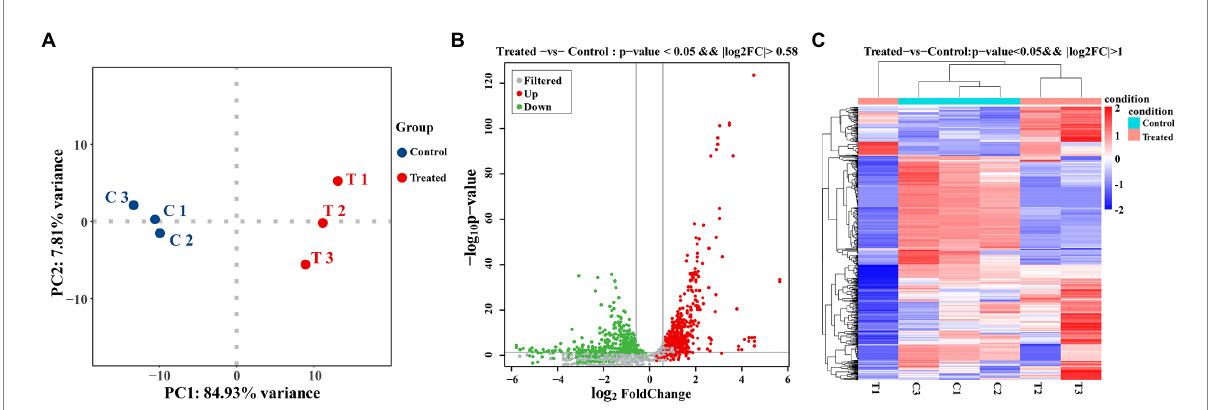
FIGURE 4 PCA analysis between the group with FCS treatment and the control group (A) . The volcano diagram of DEGs after FCS treatment compare to the control (B) . Cluster analysis of DEGs after FCS treatment, in which red cluster represents up-regulated and blue cluster represents down-regulated (C)